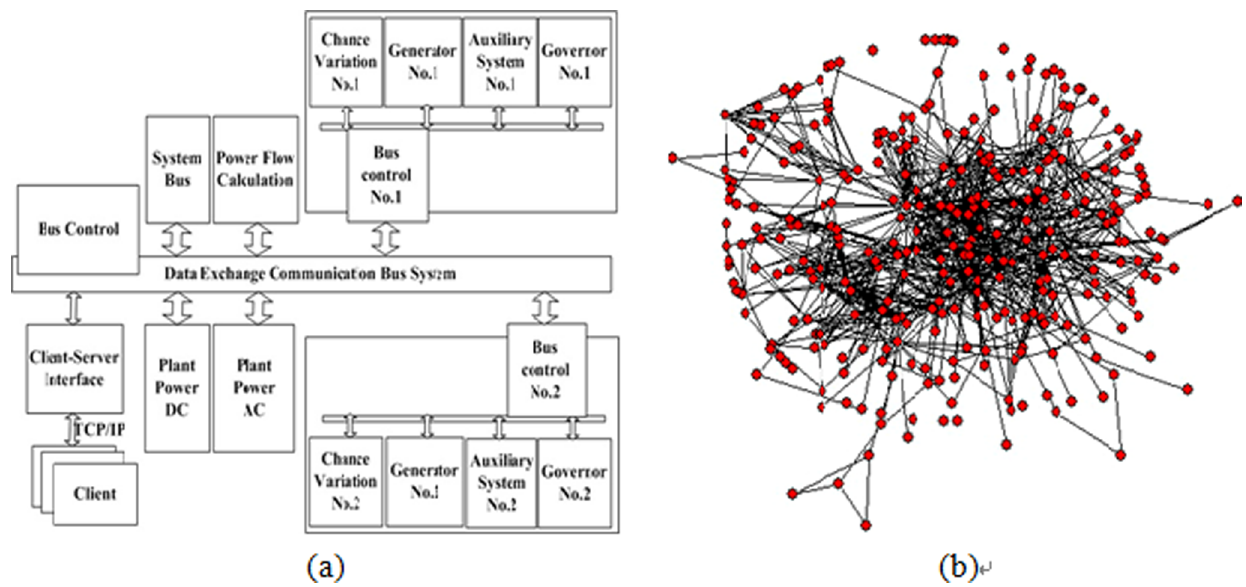
Figure 8. Architecture and network of the hydropower simulation system. (a) Architecture. (b) Network ( N =310, M =850). The software system is developed by Embedded Technology Key Lab in Northeastern University (www.netology.cn) for the Fengman hydropower station in China.